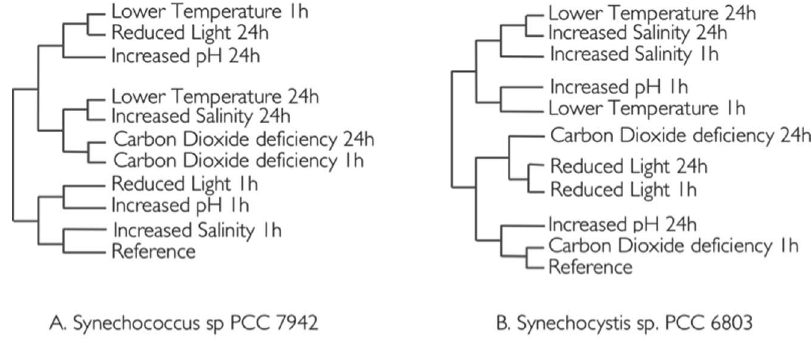
Figure 2. Hierarchical clustering of stress conditions for Synechococcus sp. PCC 7942 and Synechocystis sp. PCC 6803. doi:10.1371/journal.pone.0109738.g002 PLOS ONE |